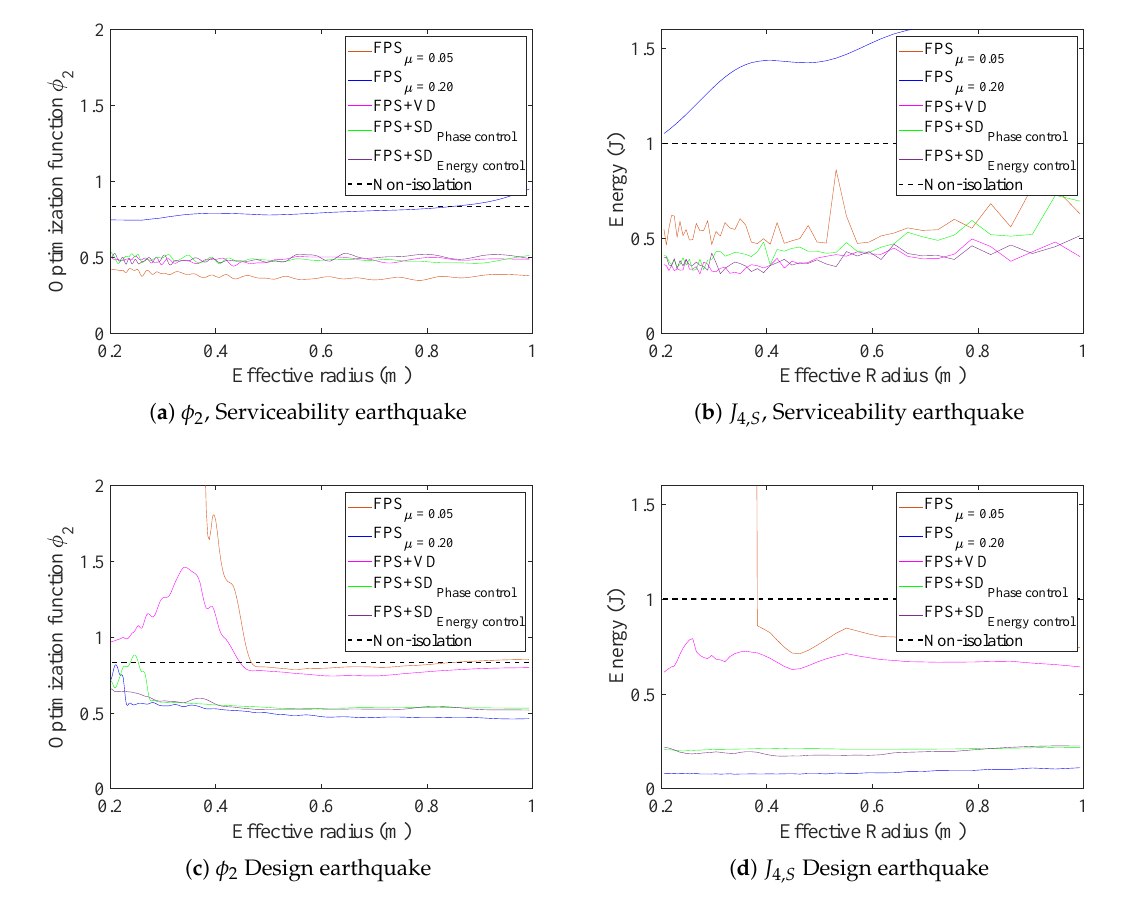
Figure 18. Performance function φ 2 and structure energy for a range of effective FPS